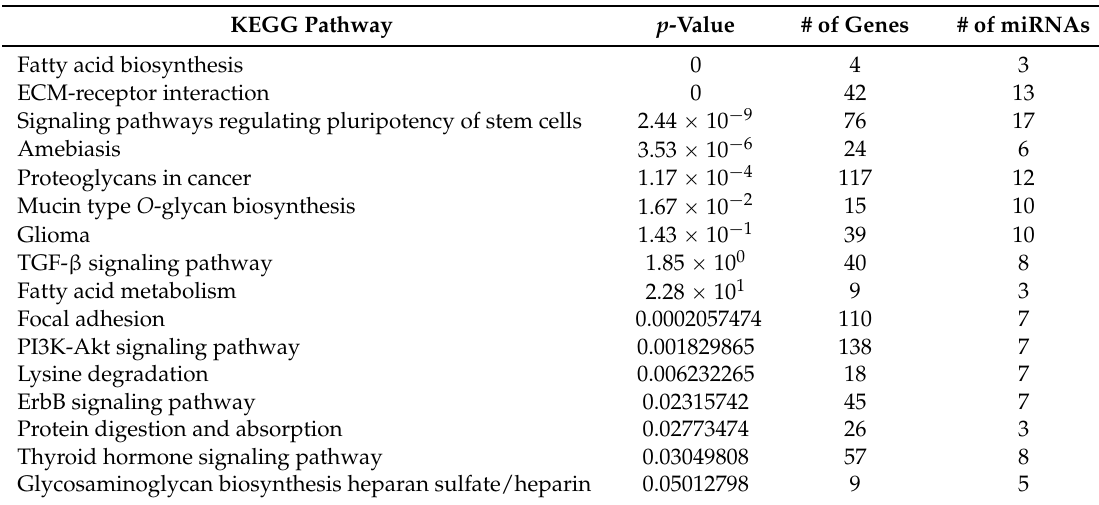
Table 4. Enriched KEGG pathways for predicted targets of the DD / DDR microRNAs modulated by